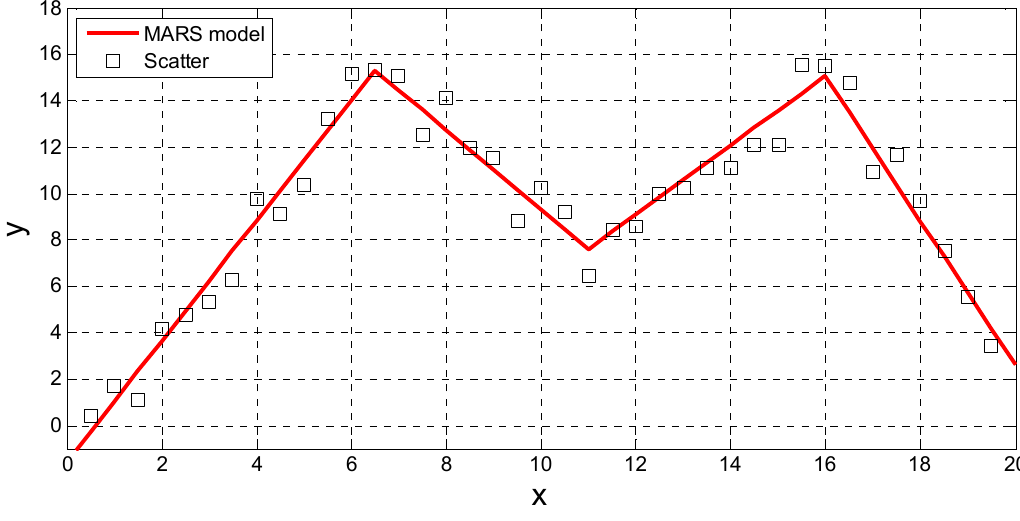
Figure 6. Knots and linear splines for a simple MARS example.